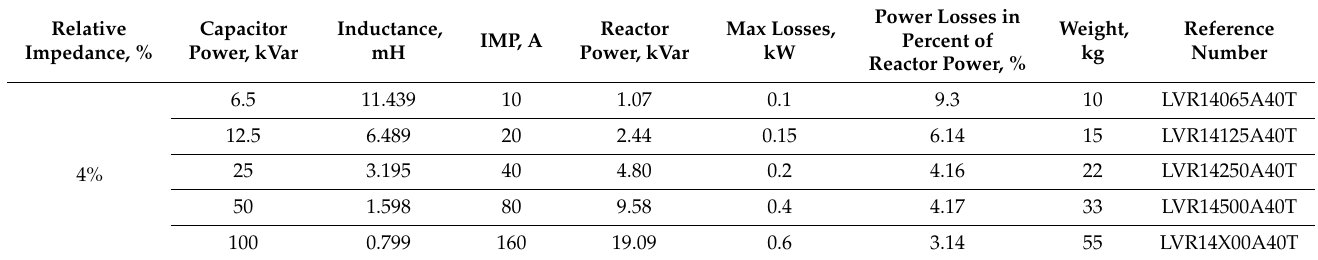
Table 3. Inductive reactors of Schneider electric designed for 400 V, 50 Hz PDL.